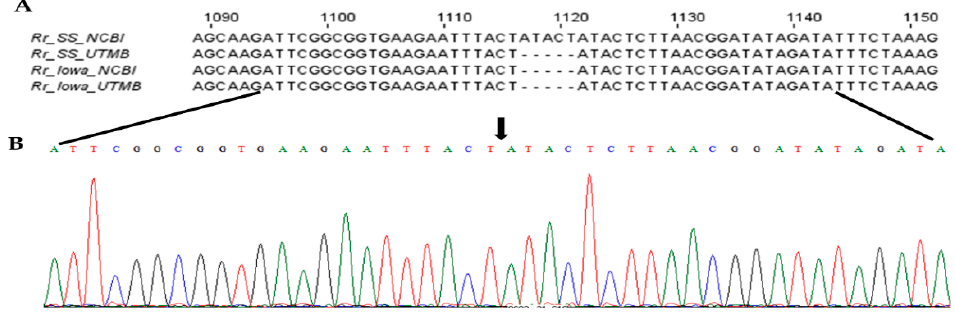
Figure 3. The nucleotide sequence and chromatogram showing the absence of 5-base insertion in the pleD gene of R. rickettsii str. Sheila Smith. The full-length pleD from R. rickettsii strains Sheila Smith (Rr_SS_UTMB) and Iowa (Rr_Iowa_UTMB) were sequenced and aligned with sequences available in NCBI (Rr_SS_NCBI and Rr_Iowa_NCBI). The sequence alignment ( A ) and chromatogram ( B ) show the absence (shown by black arrow) of ‘ATACT’ indel in pleD sequence of R. rickettsii str. Sheila Smith.